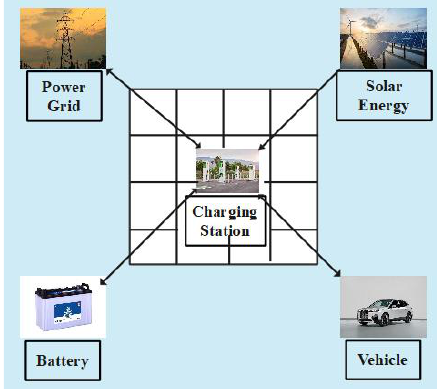
Figure 1. Overview of proposed model.